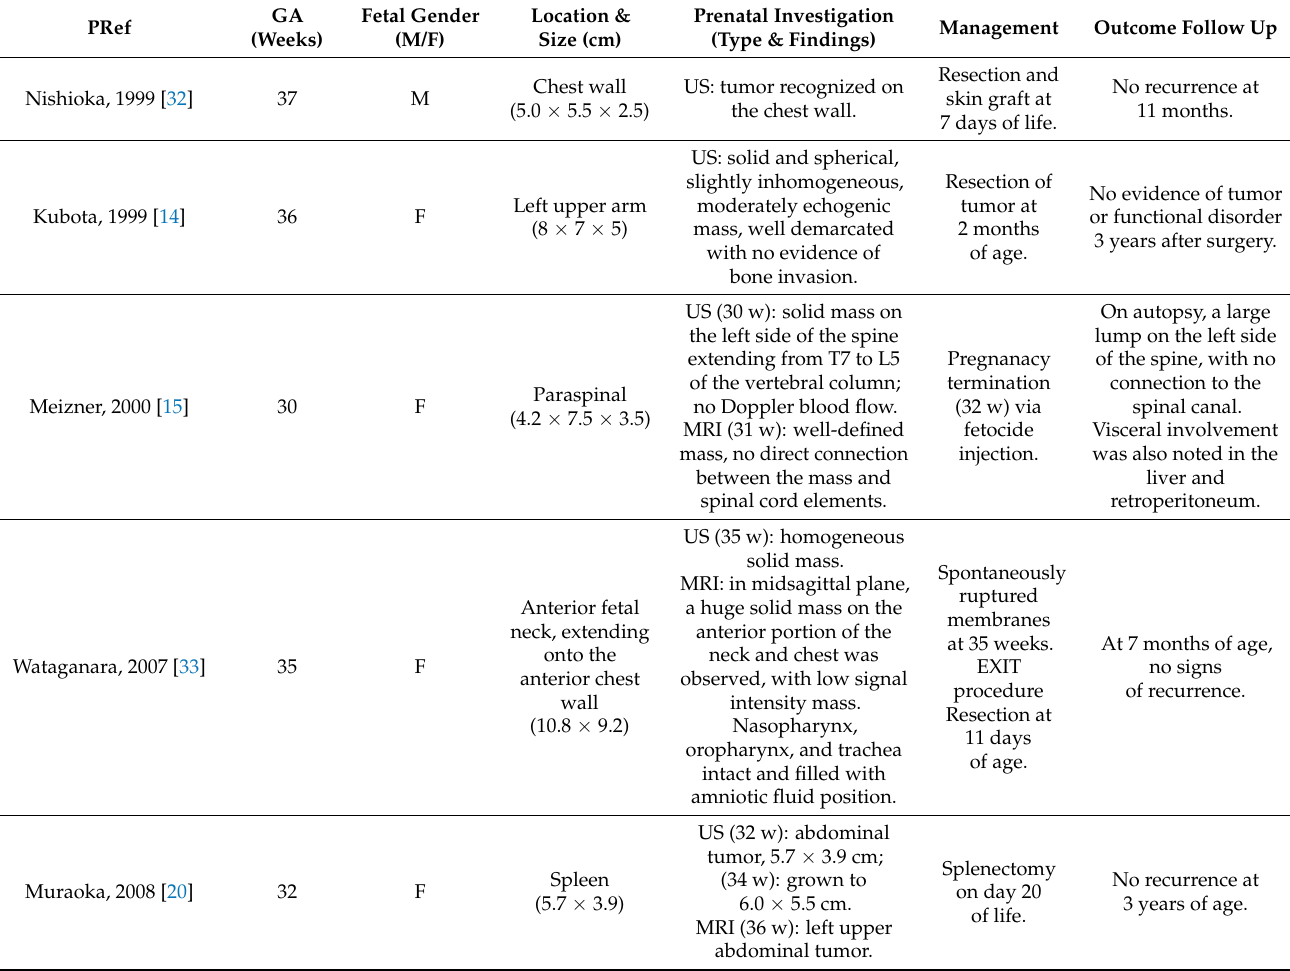
Table A1. Cases with prenatal diagnsosis, their characteristics, management and